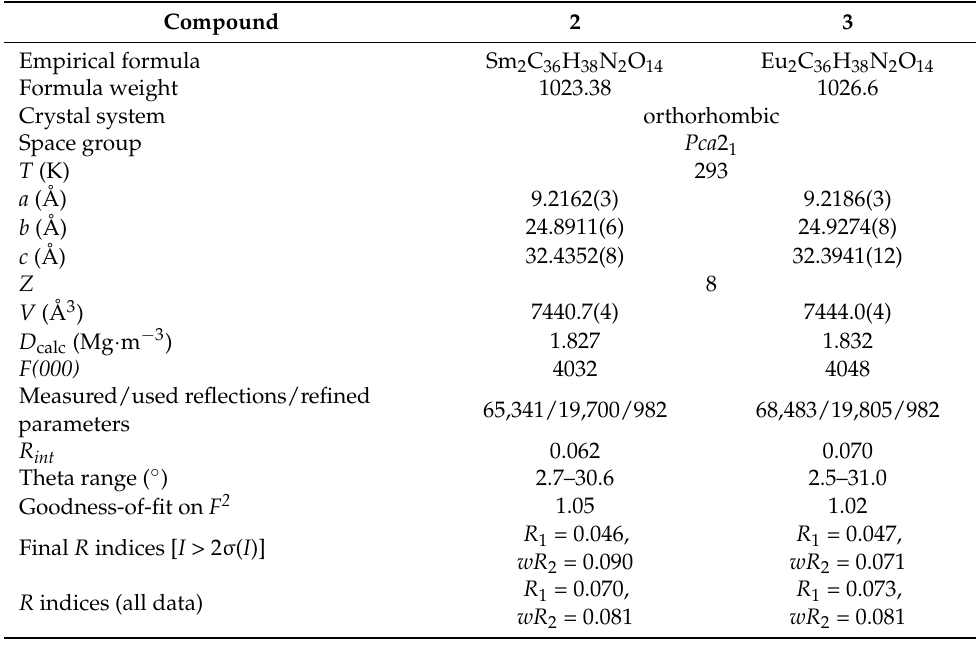
Table 1. Crystallographic data for complexes 2 and 3